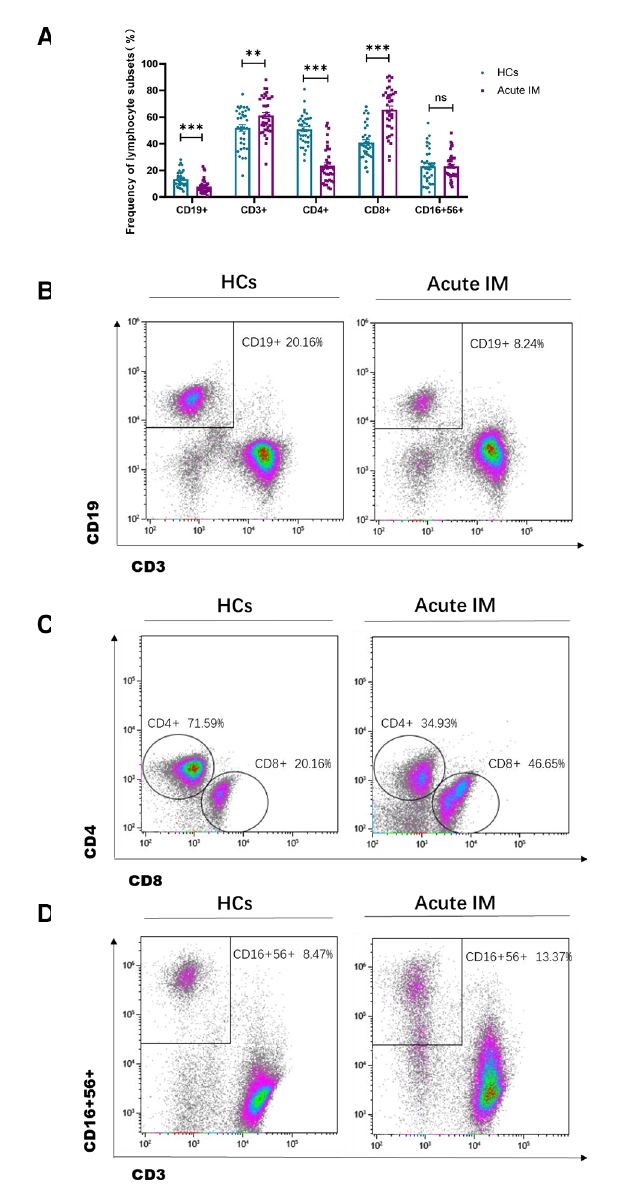
FIGURE 1 Analysis of the lymphocyte subsets characteristic in pediatric patients with infectious mononucleosis (IM) and in healthy control. ( A ) The frequency of T cells, B cells, and NK cells in patients with IM and healthy control were expressed as the mean with standard deviation (SD). ( B-D ) Representative dot plots showing the frequency of T cells, B cells, and NK cells. ** P < 0.01, *** P <